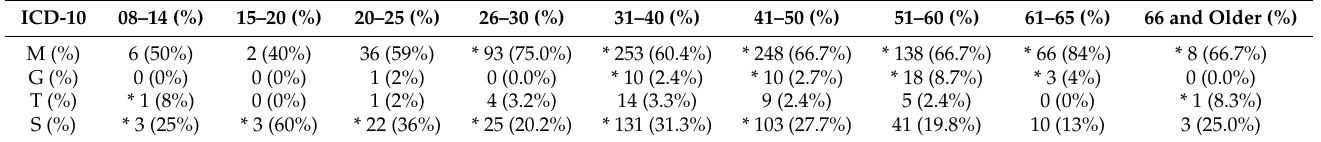
Table 6. The table presents the relationships between the most frequent diagnoses and a specific age range. * Upper index stars reflect the significance ( p = 0.001).